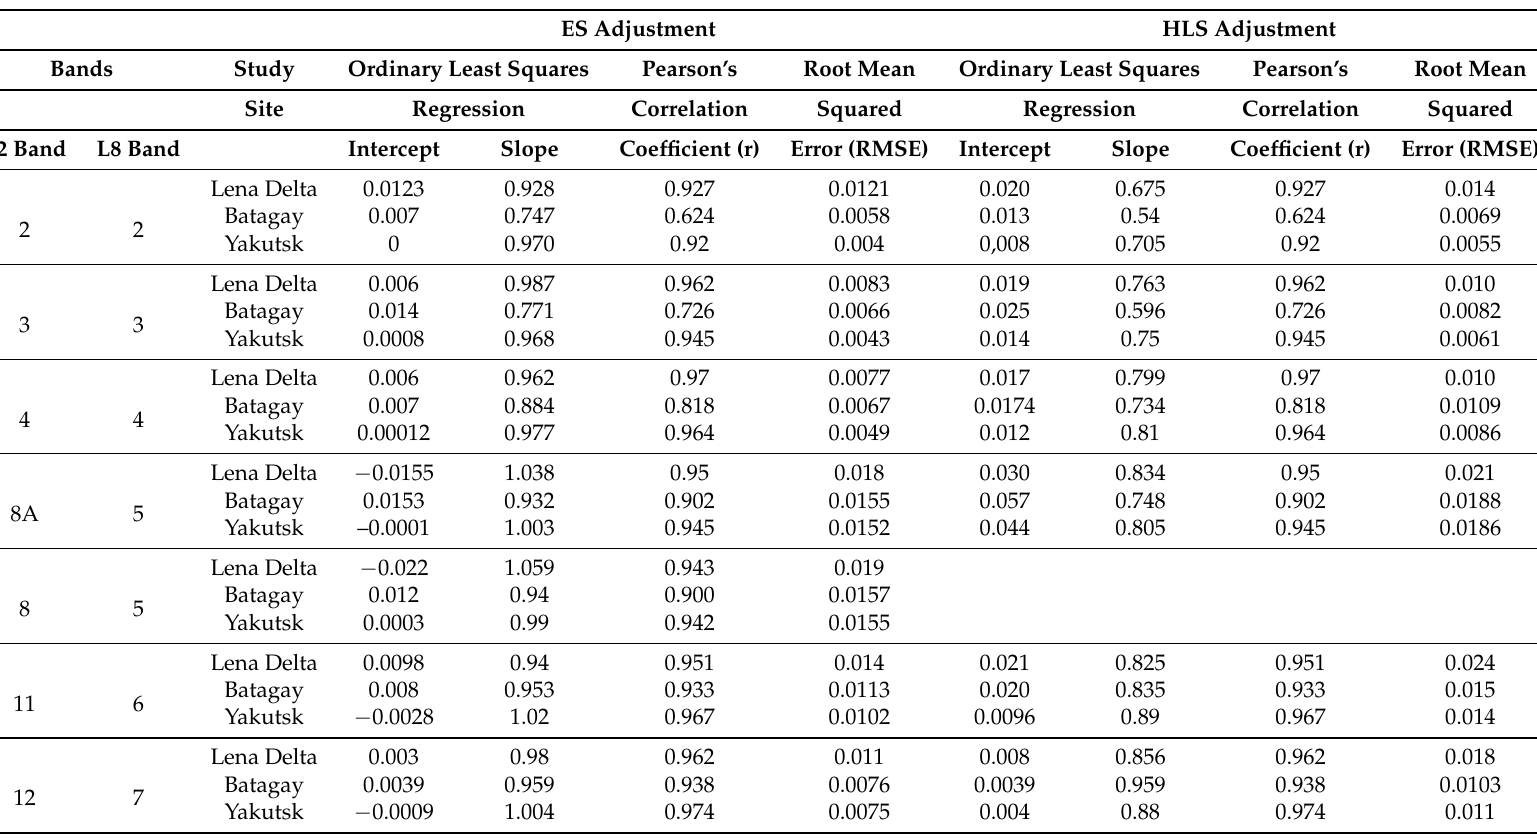
Table 6. Comparison of surface reflectance values from the Sentinel-2 and Landsat-8 corresponding bands after spectral band adjustment, for same-day acquisitions, using the Eastern Siberian (ES) and Harmonized Landsat and Sentinel-2 (HLS) adjustment coefficients. Displaying the results of the ordinary least squares regression, Pearson correlation, and root mean squared